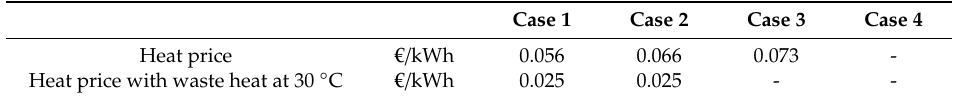
Table 6. Heat price for di ff erent